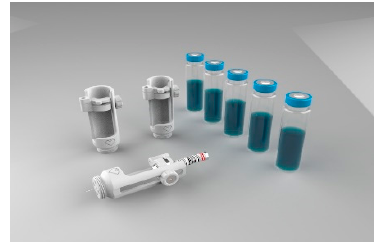
Figure 3. The SPME Multi Off-Line Sampler.